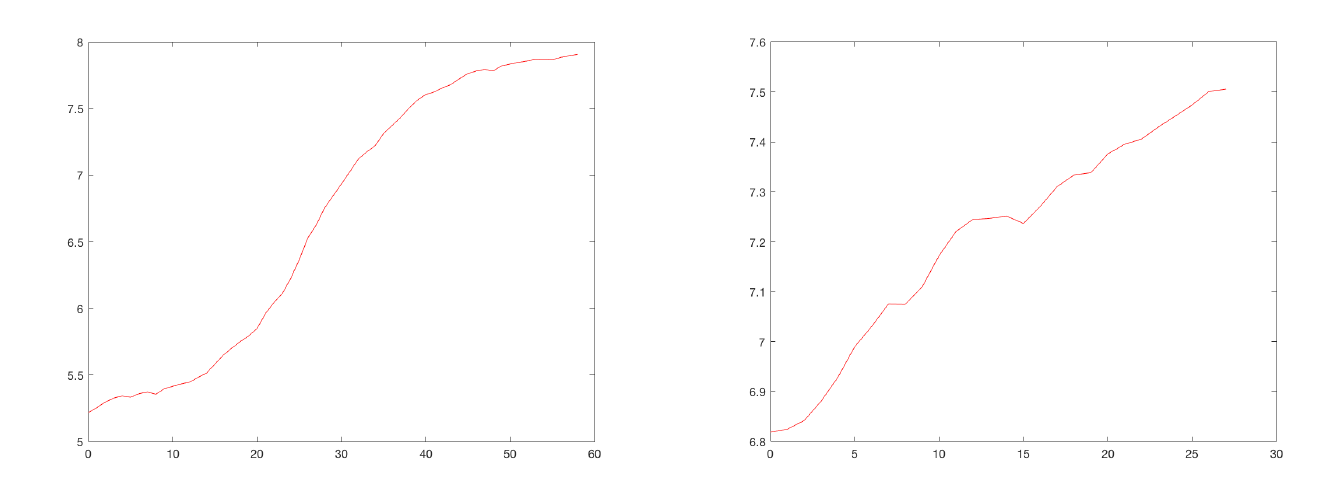
Rise 1 Rise 2 Figure A30. Roma’s rises. Horizontal axis, days; vertical axis: logarithm of daily cases.